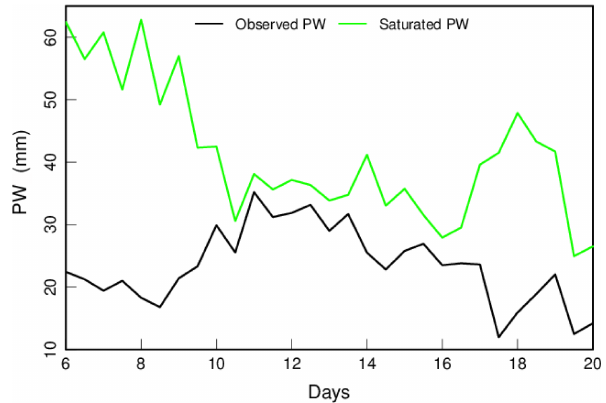
Figure 4. A time series comparison of observed radiosonde PW (black line) and saturated PW (green line) for 1–28 September 2013 over Denver, Colorado.